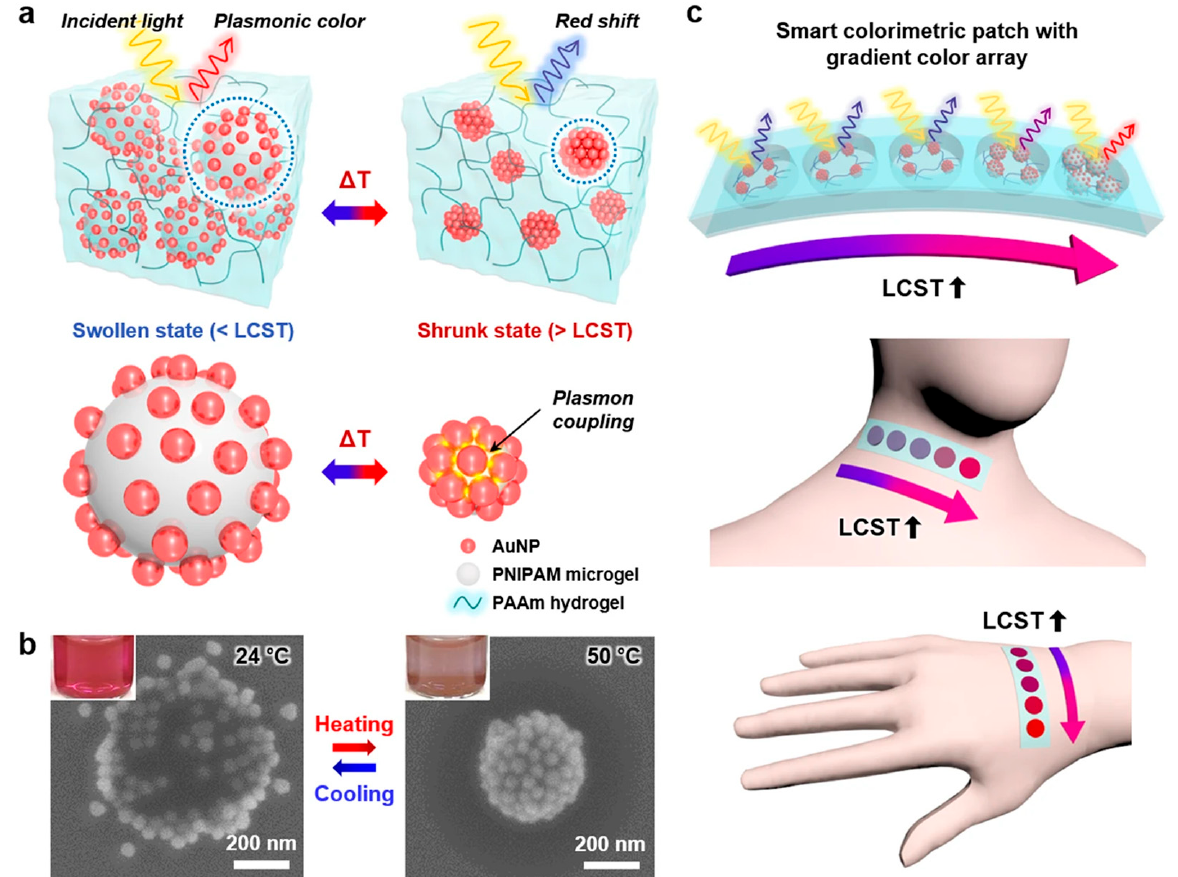
Figure 2. ( a ) Schematic illustration of the plasmonic microgels in the PAAm hydrogel under swollen and shrunken states. ( b ) SEM images of the plasmonic microgels with 51-nm AuNPs under the swollen state at 24 °C (left) and under the shrunken state at 50 °C (right); the inset images show pictures of the plasmonic microgel dispersions under each condition. ( c ) Schemes of the sensor array patches attached to human skin at different positions (neck and hand). (Reprinted from Ayoung Choe et al. [47], NPG Asia Materials, 10 September 2018 10; DOI: 10.1038/s41427-018-0086-6; licensed under Creative Commons CC BY li (open access)).